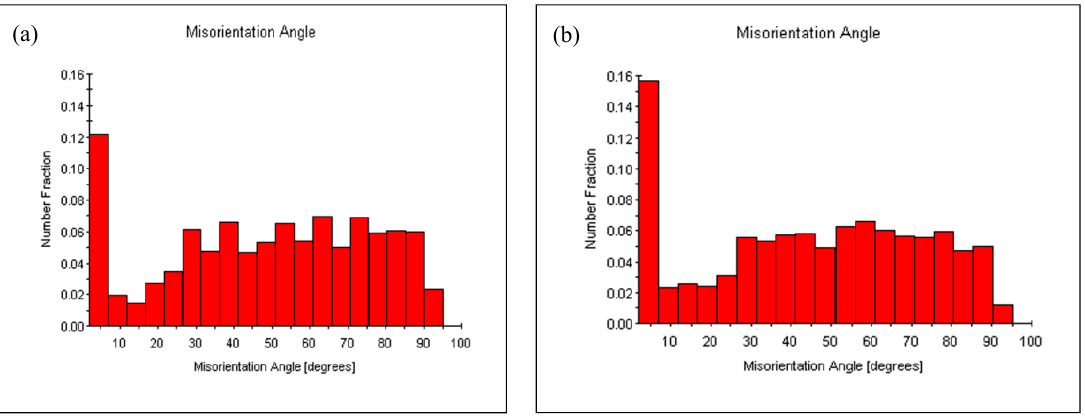
Figure 7. Misorientation angle distribution for boundaries in the forged and extruded alloy, compressed at room temperature: ( a ) forged alloy; ( b ) extruded alloy.